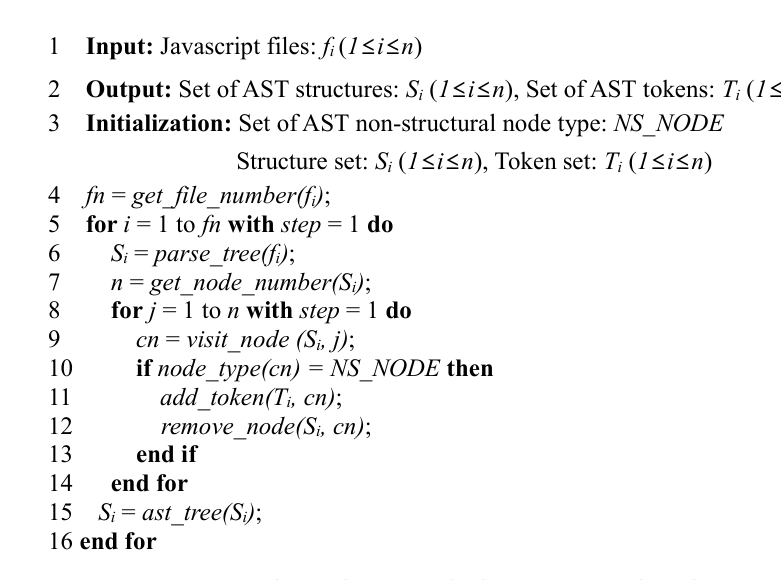
Figure 2. Lightweight AST and token extraction algorithm.